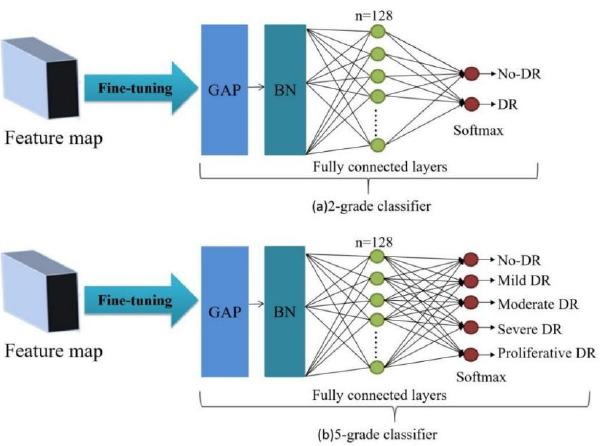
Figure 7. The proposed 2-grade and 5-grade classifiers for classification.